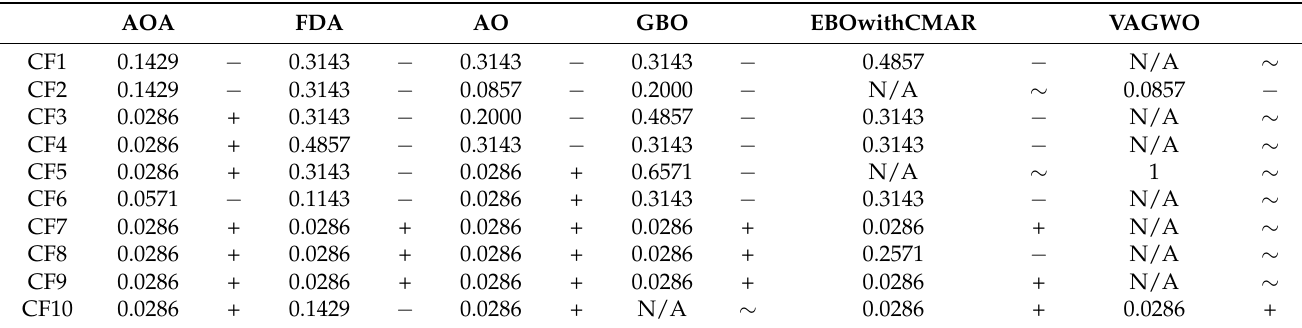
Table 12. p -values and signs of Wilcoxon test for VAGWO against the newly proposed algorithms on the CEC2017